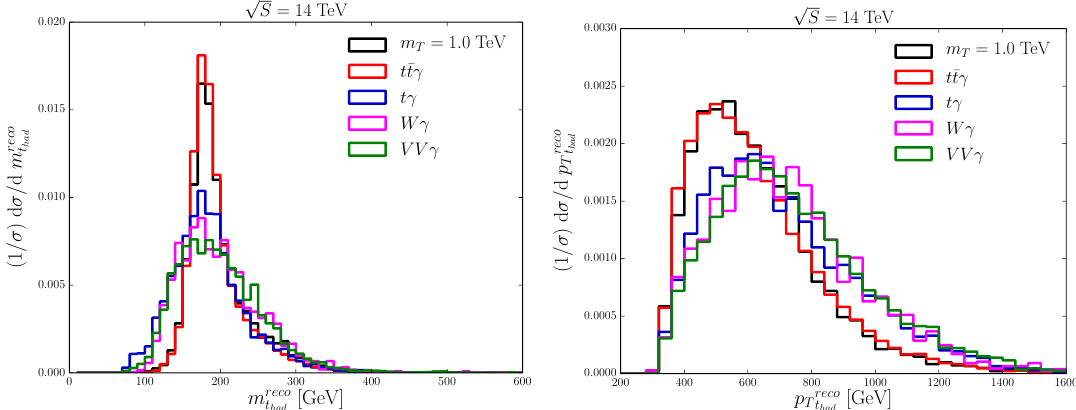
Figure 6 . The reconstructed invariant mass distribution of the top-tagged fat jet (left) and the corresponding p T distribution (right) in the ttg(cid:13) channel for m T = 1 : 0 TeV.